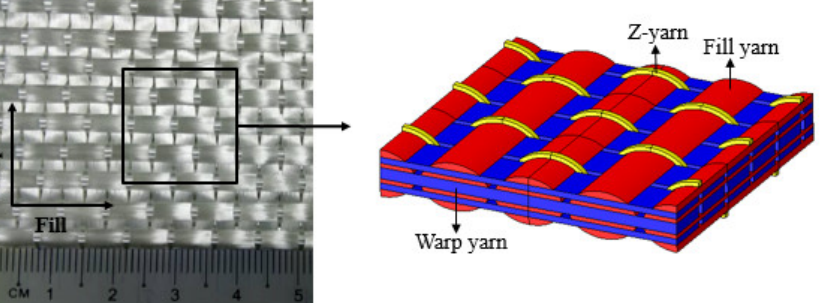
Figure 2. 3D orthogonal woven fabric